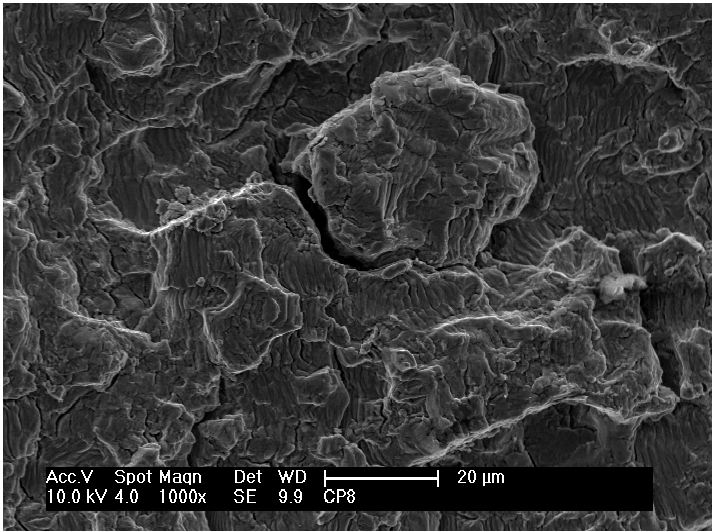
Figure 10. Scanning electron micrograph of the fracture surface of the plasma nitrided specimen that was fatigue tested at 406 MPa and 90,800 cycles to failure.